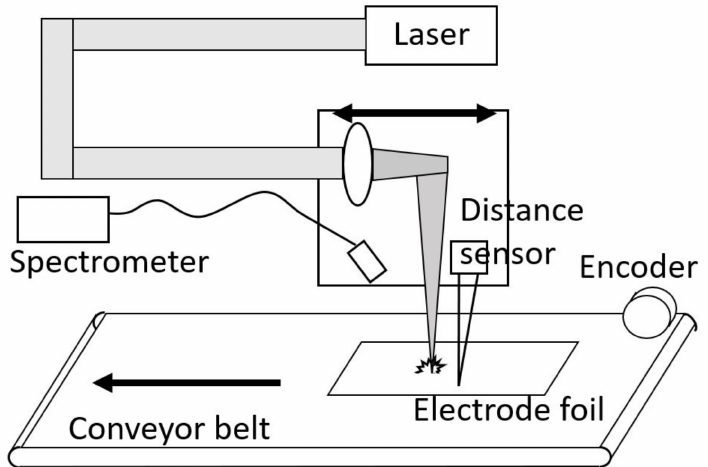
Figure 1. Sketch of the LIBS machine for inline depth profile measurements. The focusing lens is mounted on a motorized stage aligned along the movement of the conveyor belt. The direction of movement of the conveyor belt is indicated by the lower black arrow. The upper black double arrow indicates the movement of the LIBS setup, including the focusing lens and the deflection mirror of the pulse laser, and the detection lens for the plasma light. The synchronous movement is controlled by the signal of an